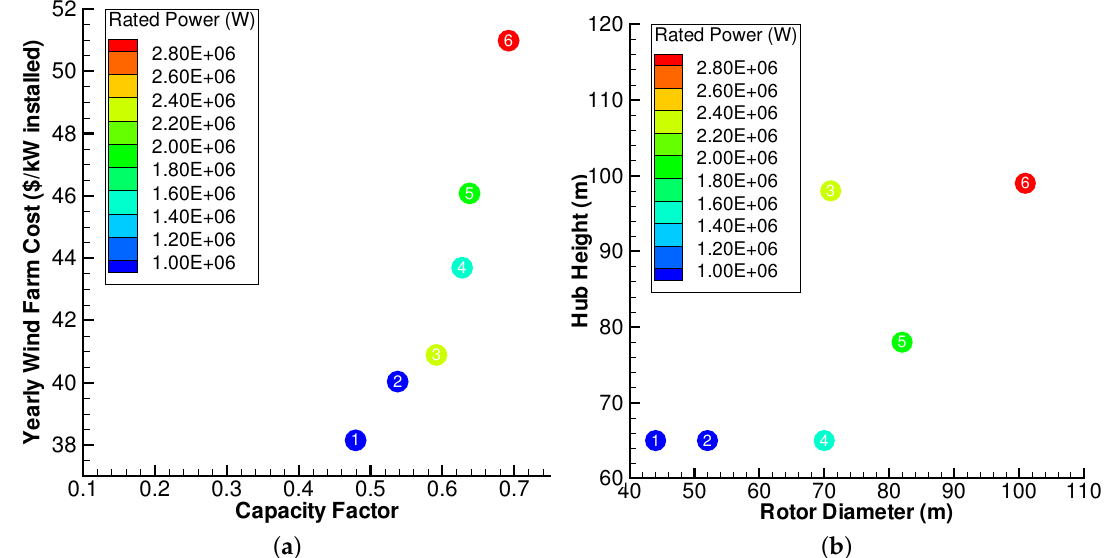
Figure 18. Tradeoffs offered by the best performing turbines of different rated powers for Case V: Class 5–6 winds. ( a ) Best tradeoffs between the capacity factor and average annual cost ($/kW installed); ( b ) rotor diameters and hub heights of the best tradeoff turbines.